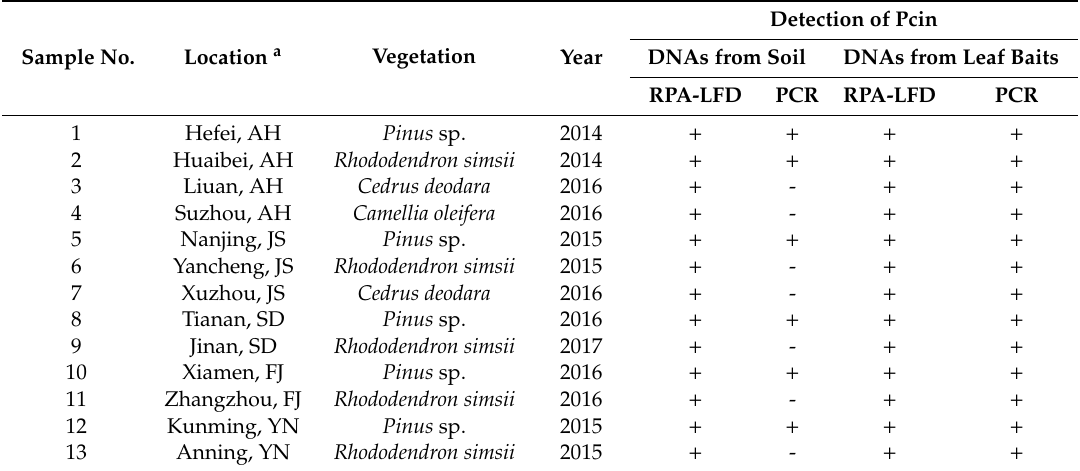
Table 3. Detection results of Phytophthora cinnamomi in 13 infested soil samples using the recombinase polymerase amplification-lateral flow dipstick (RPA-LFD) and PCR assays. Sample No. Location a Vegetation Year